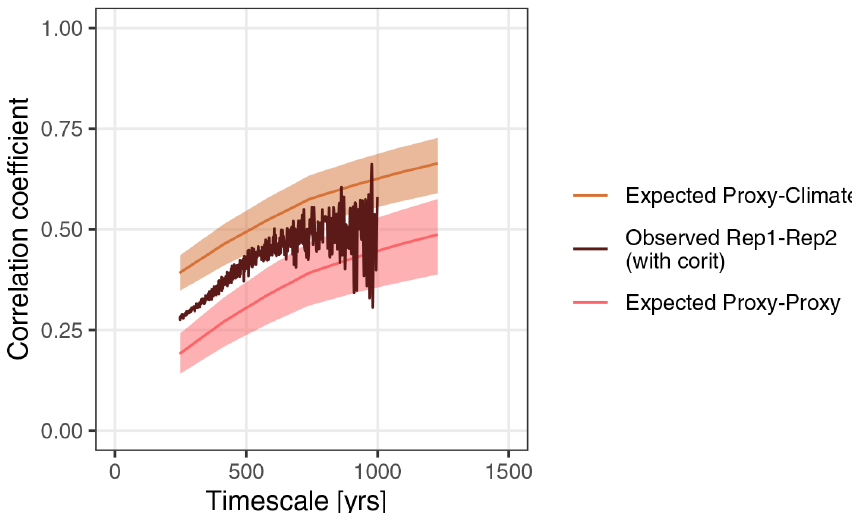
Figure 9. Timescale-dependent correlation between replicated δ 18 O records at GeoB 10054-4 and their expected correlation with each other and with the true climate. The dark brown curve shows the observed timescale-dependent correlation between the replicate proxy records Rep1 and Rep2. The light brown and pink curves show the expected correlation between the two proxy records and between the proxy records and the true climate as calculated from the error spectra. The shaded areas indicate plus or minus the expected standard deviation in the correlation